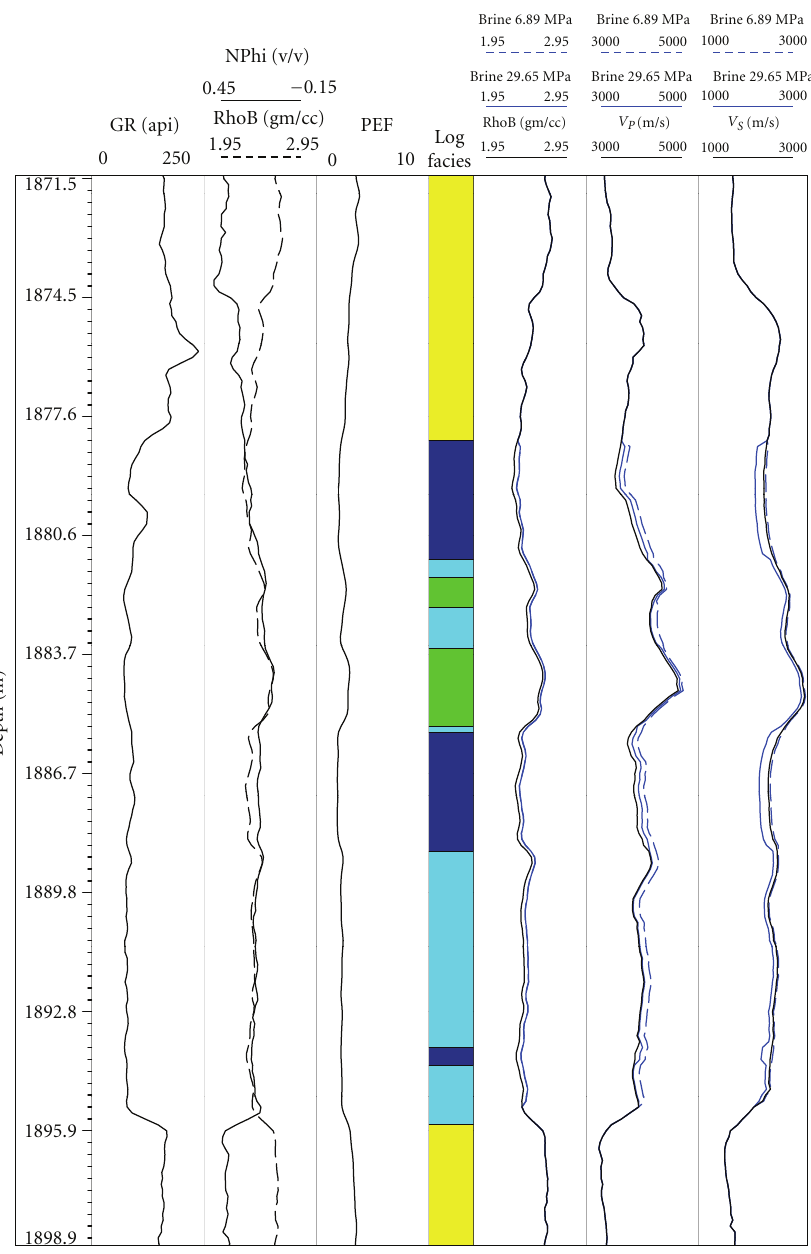
Figure 16: Estimated changes in the Morrow A sandstone for P-wave velocity, S-wave velocity, and bulk density log response for conditions of complete brine saturation at pore pressures of 6.89 MPa (blue dashed lines) and 29.65 MPa (solid blue lines). The recorded in-situ P-wave velocity, S-wave velocity, and bulk density logs are shown in